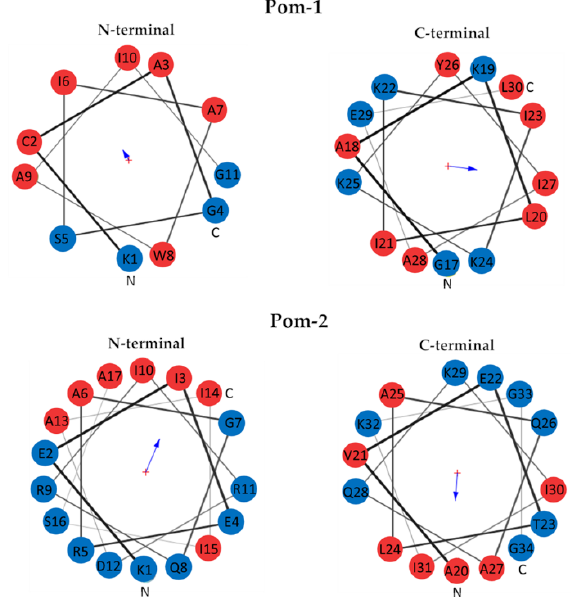
Figure 2. Helical wheel diagrams of N-terminal and C-terminal helix of Pom-1 (top) and Pom-2 (bottom). Hydrophobic residues are displayed in red, hydrophilic residues in blue. The arrow size is proportional to the hydrophobic moment and points to the hydrophobic side of the helix.